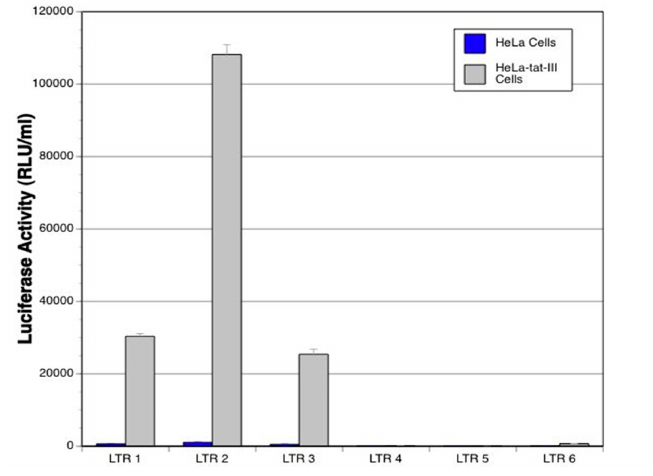
Figure 2. Comparison of luciferase gene expression from wild type LTR and LTR mutant clones (shown in Figure 1) in HeLa cells and HeLa-tat-III cells that constitutively express the HIV-1 Tat protein (data from [39]).